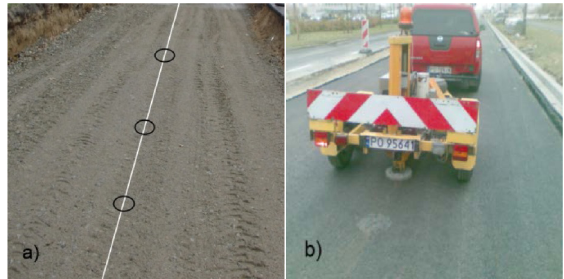
Fig. 5. Surfaces of layers prepared for FWD